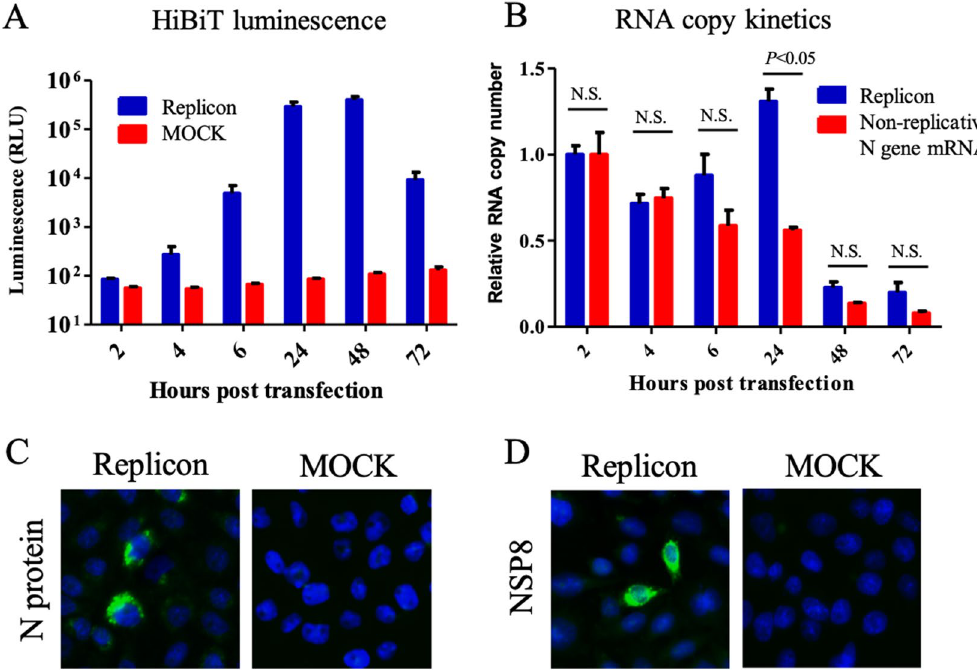
Figure 2. Characterization of a SARS-CoV-2 replicon. ( A ) Kinetics of luminescence signal. The CHO-K1 cells were electroporated with 5 μg of replicon RNA. Intracellular luminescence signals were measured at the indicated time points. The mean and standard error of two independent experiments are shown in this figure. ( B ) Kinetics of the RNA copy. The CHO-K1 cells were electroporated with 10 μg of either the replicon RNA or the non-replicative N gene mRNA. RNA copy numbers were subsequently measured using qRT-PCR. The results were expressed as relative RNA copy number compared to that at 2 hpt. Multiple t-tests were performed for determining the statistical significance. A p -value < 0.05 was considered to be statistically significant. NS not significant. ( C ) The detection of N protein by IFA. The CHO-K1 cell was electroporated with 5 μg of replicon RNA. The cells were fixed with 4% paraformaldehyde, followed by permeabilization with 0.5% Triton-X. The expression of N protein was detected using anti-N mAb and goat-anti-mouse IgG conjugated with Alexa Fluor 488. Nucleus was stained by DAPI. ( D ) The detection of NSP8 protein by IFA. The expression of NSP8 protein was detected using anti-NSP8 mAb and goat-anti-mouse IgG conjugated with Alexa Fluor